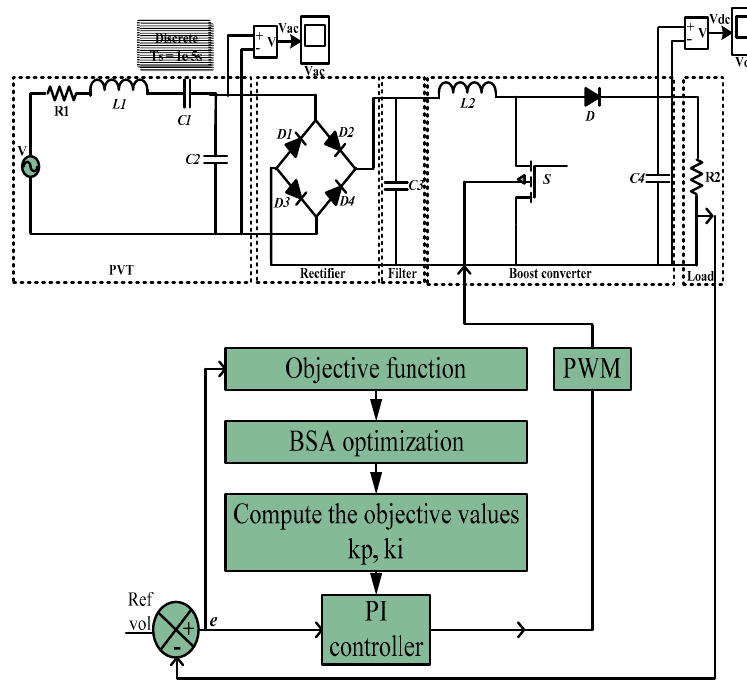
Figure 5. Block diagram of the proposed BSA-based PI voltage controller for piezoelectric energy harvesting system (PEHS).